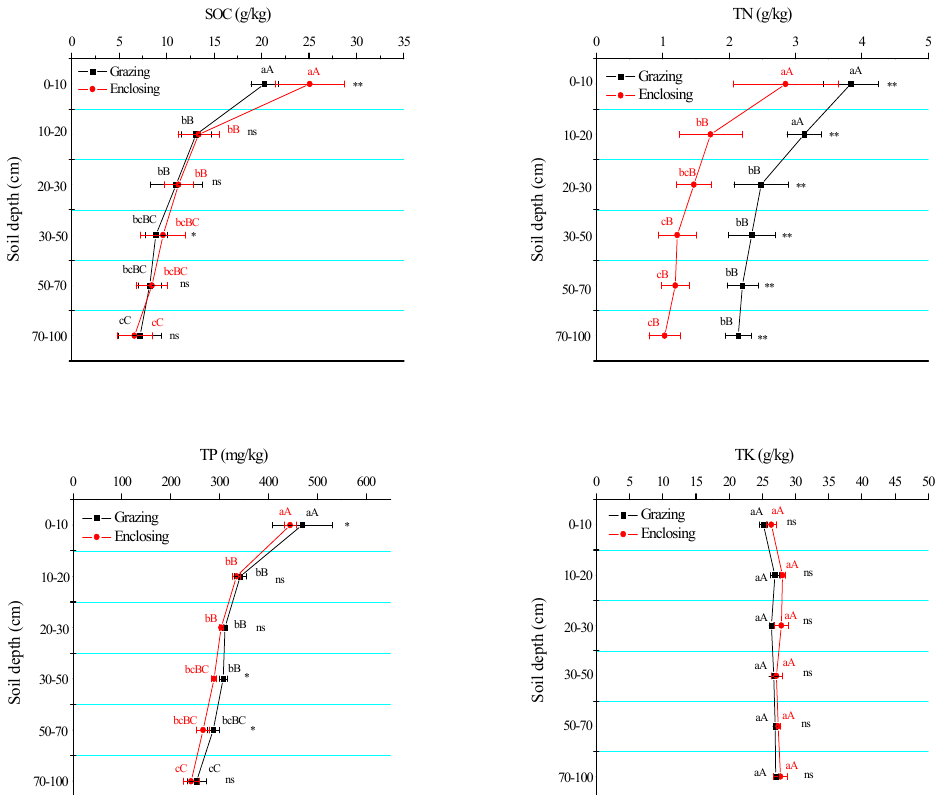
Figure 1. The effects of long term grazing and enclosing on the contents of soil SOC, TN, TP and TK. Note: * and ** indicate significant differences at p < 0.05 level and p < 0.01 level of SOC, TN, TP and TK contents in each soil layer between the long term grazing plot and the long term enclosing plot and ns indicates no significant difference ( t test). Different lower case and capital letters indicate significant differences at p < 0.05 level and p < 0.01 level of SOC, TN, TP and TK contents among different soil layers for the long term grazing plot or the long term enclosing plot by one-way analysis of variance (ANOVA). Error bars were one standard deviation.